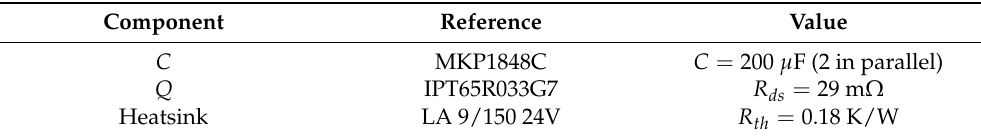
Figure 8. Mounted inductance for the ( a ) HB ( L = 150 µ H and R L = 26 m Ω ) and ( b ) MSIBC ( L = 75 µ H and R L = 31 m Ω ). Table 7. Selected capacitor, semiconductor, and heatsink for the single and the double inductor topologies.